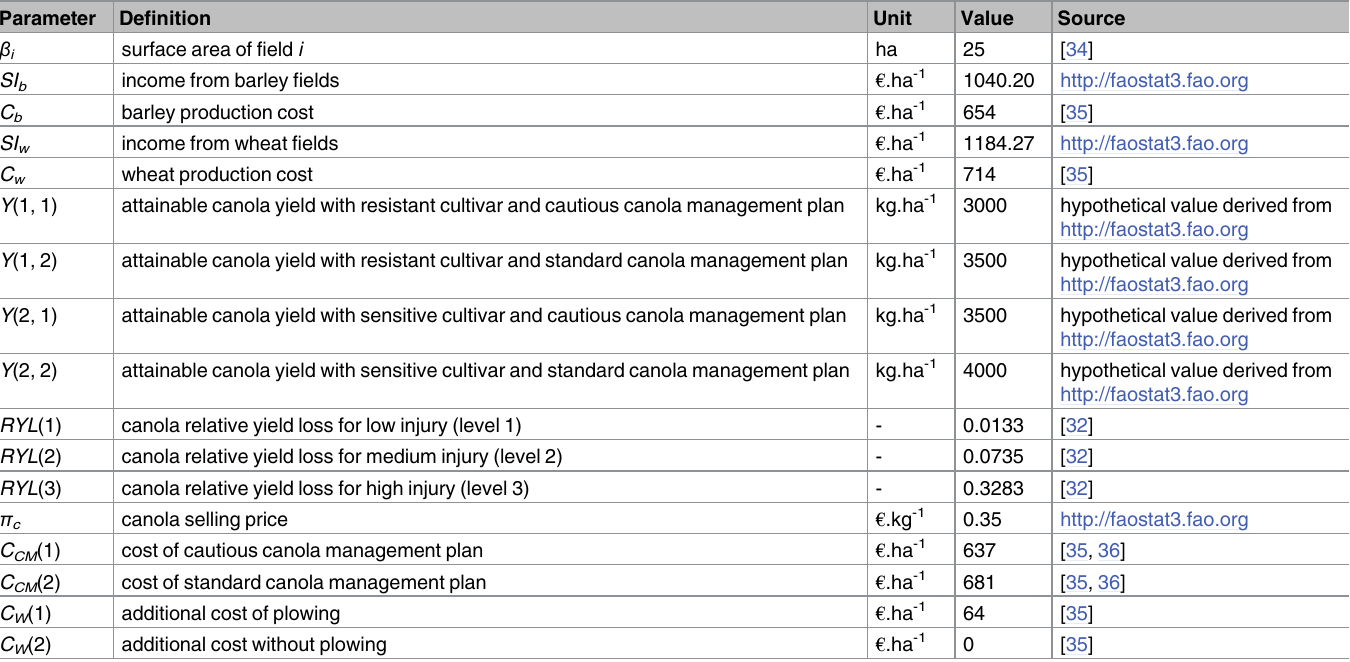
Table 6. Parameters defining the reward function in the GMDP model of management of blackleg on